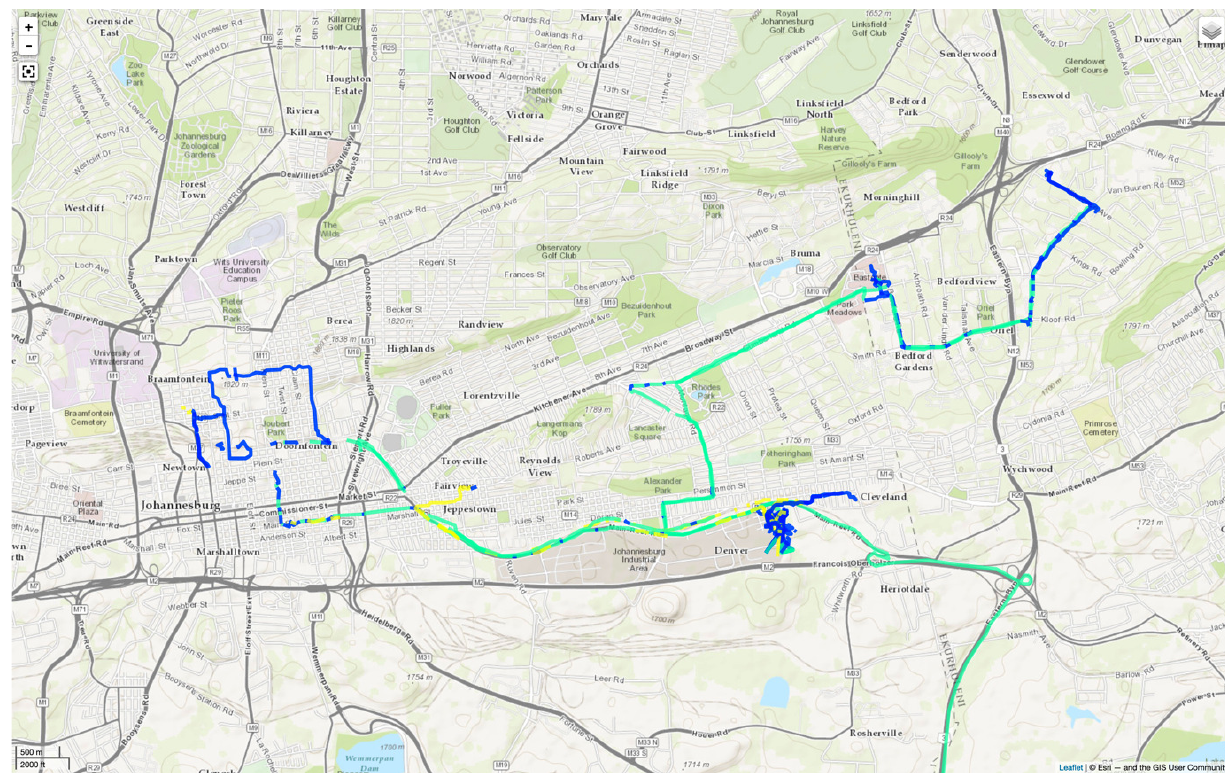
Figure 4. A map of typical patterns of movement by participant D6 around Denver, in which the blue lines indicate walking. Source: Map by Chantal Bekkering,